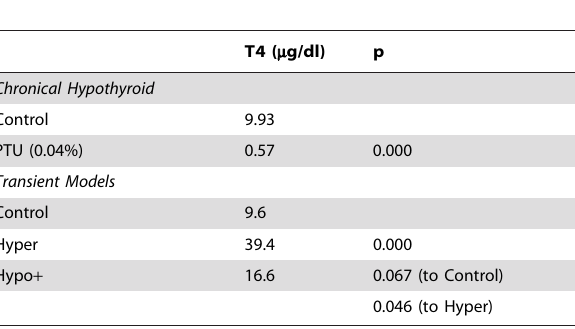
Table 2. Serum T4 levels of male pups in the various animal models (n